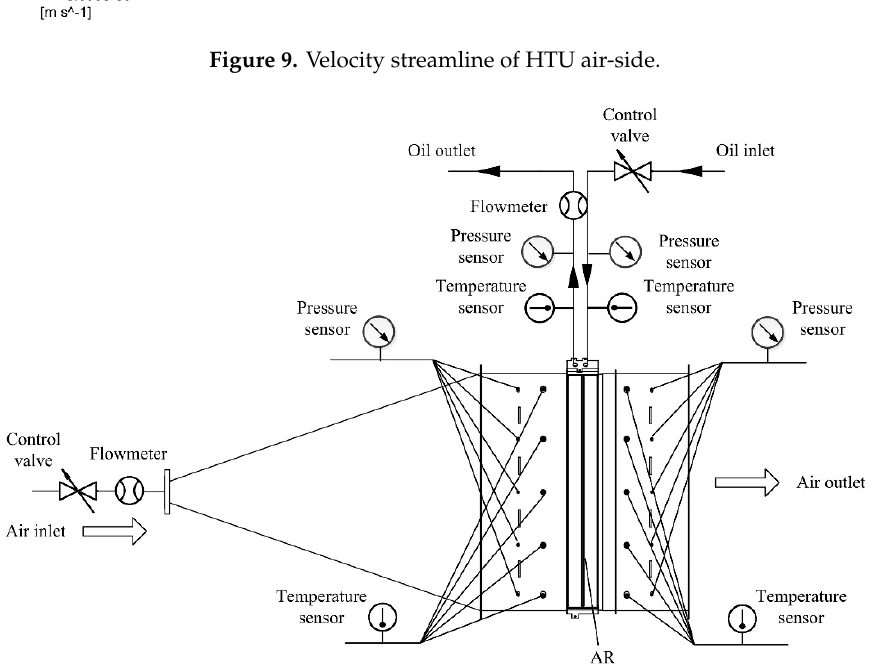
Figure 10. Experimental schematic diagram.